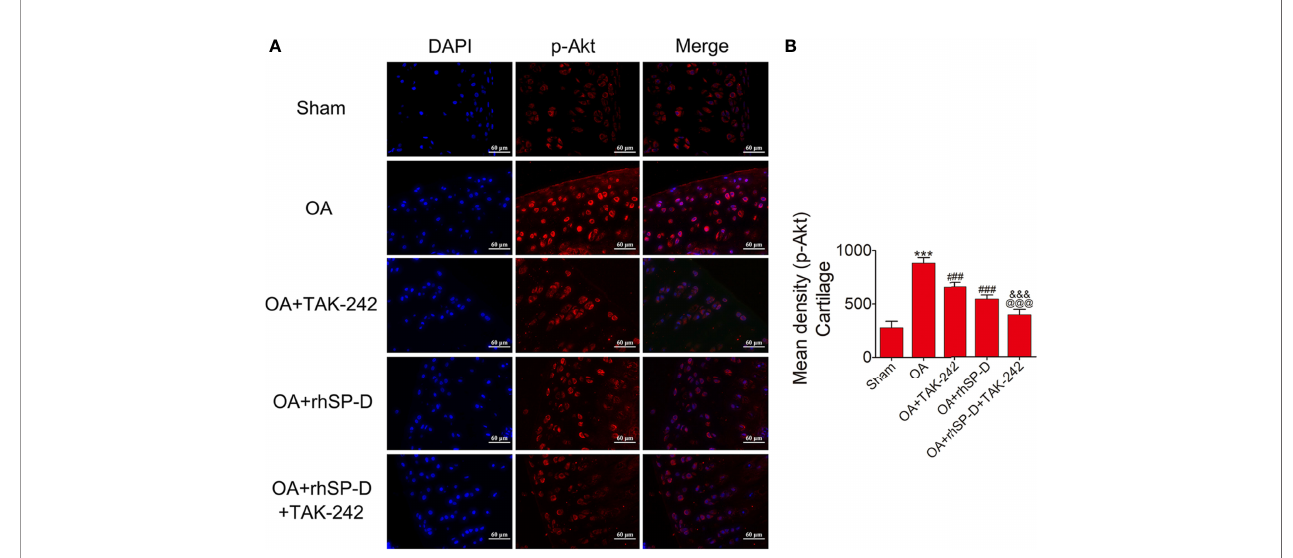
FIGURE 6 | SP-D modulated TLR4-mediated Akt signaling in vivo . (A) Immuno fl uorescence with an antibody to p-Akt in articular cartilage from the ACLT + MMx -induced OA rats with rhSP-D and TAK-242 treatment at 10 weeks post-surgery. (B) The ratios of immunoreactive cells were quanti fi ed in articular cartilage according to immuno fl uorescence. Data were expressed as mean ± SEM (n = 5). ***P < 0.001 vs. the sham-operated group; ### P < 0.001 vs. the OA-induction group; &&& P < 0.001 vs. OA + rhSP-D group; @@@ P < 0.001 vs. OA + TAK-242